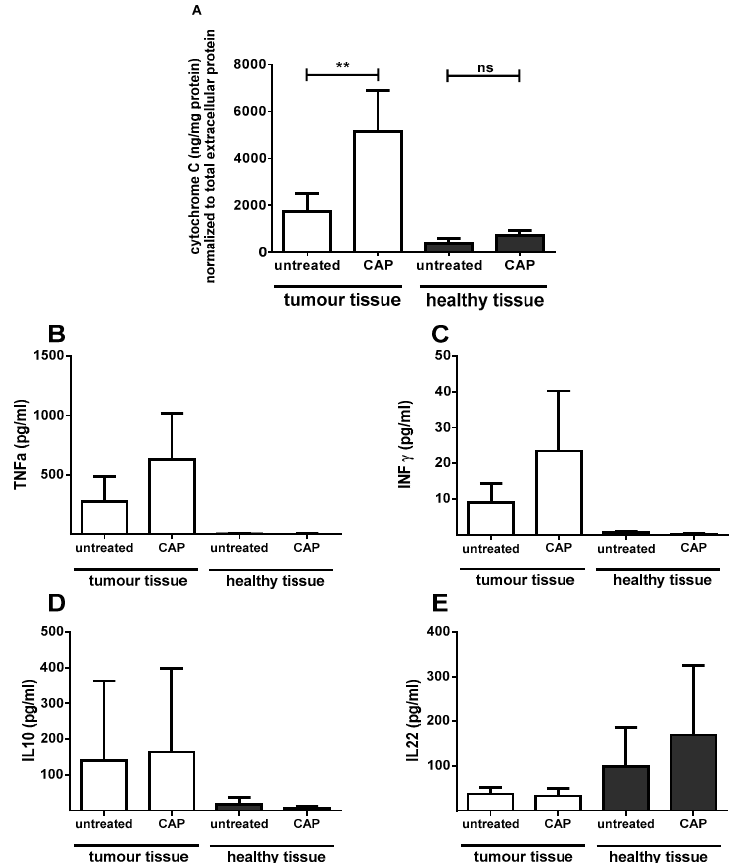
Figure 6. Detection of extracellular cytochrome c ( A ) and different cytokines ( B – E ) released by the tissue samples into the supernatant after CAP treatment. Secreted proteins were detected in the supernatant medium in which tissue specimen have been maintained for 24 h after CAP exposure. Higher extracellular cytochrome c levels were detected in tumour tissue compared to healthy mucosa of the same patient after CAP treatment (n = 9). The concentration of cytochrome c was normalized to total extracellular protein and bars represent mean + SEM. TNF α , IFN γ , IL10 and IL22 (n = 5) were simultaneously detected by a bead based immunoassay and compared between tumour tissue and healthy tissue. Bars represent mean + SEM.